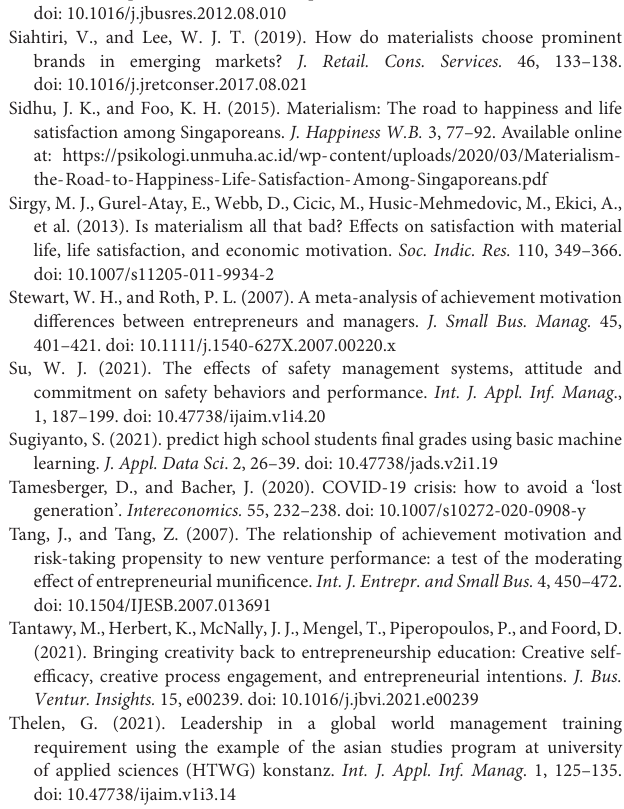
Algorithm C4.5 for Predicting Graduation Rate College student. J. Appl. Data Sci . 2, 74–83. doi: